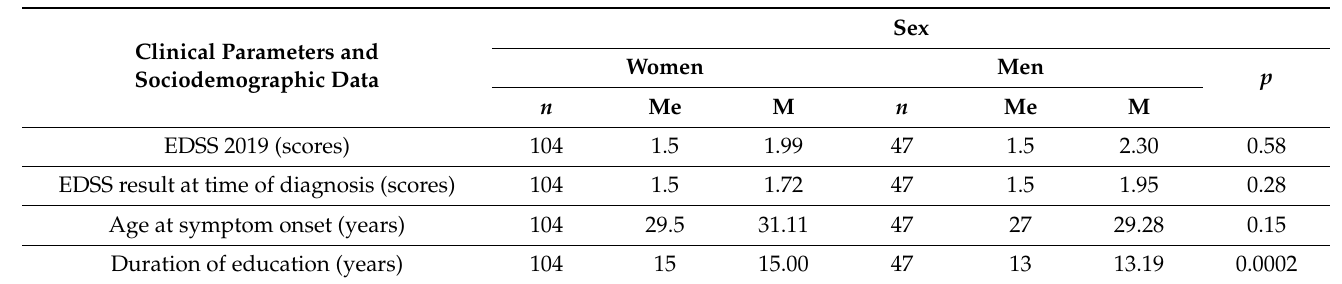
Table 1. Clinical and sociodemographic data of MS patients with regard to sex.